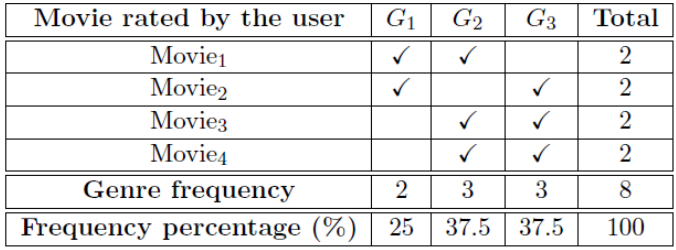
Figure 15. Example of computing the genre frequency and frequency percentage for a user.